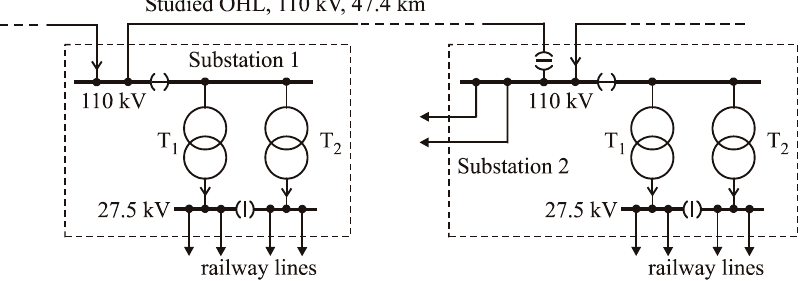
Figure 1. Simplified single-wired electrical scheme of the network area to which the studied line belongs. OHL: overhead line.